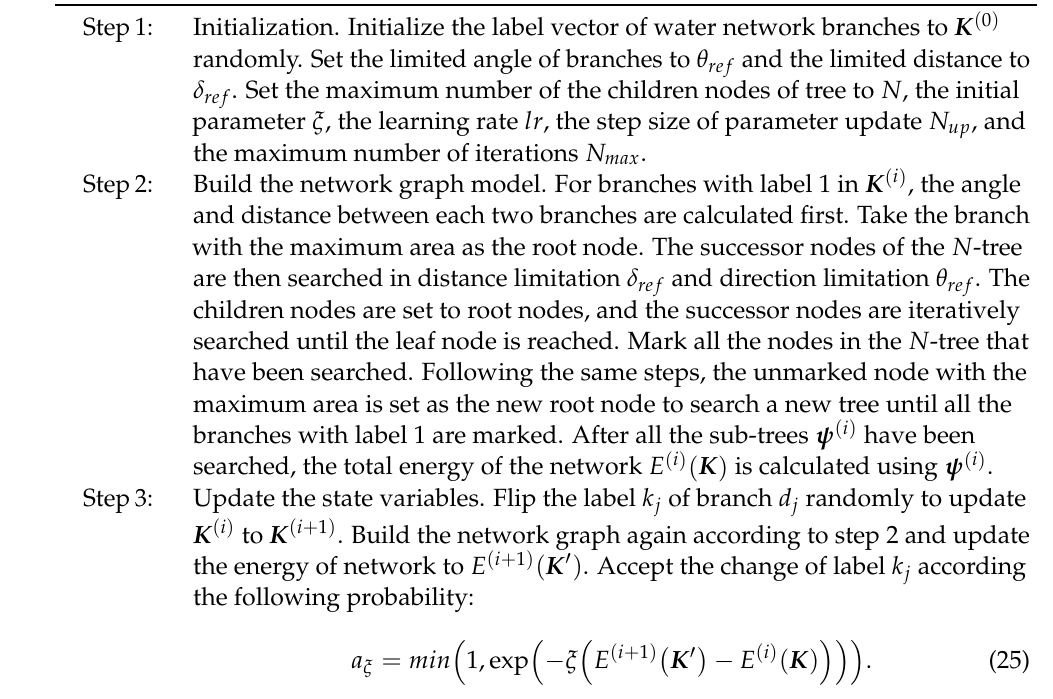
Algorithm 1: Water network construction based on Markov tree in global